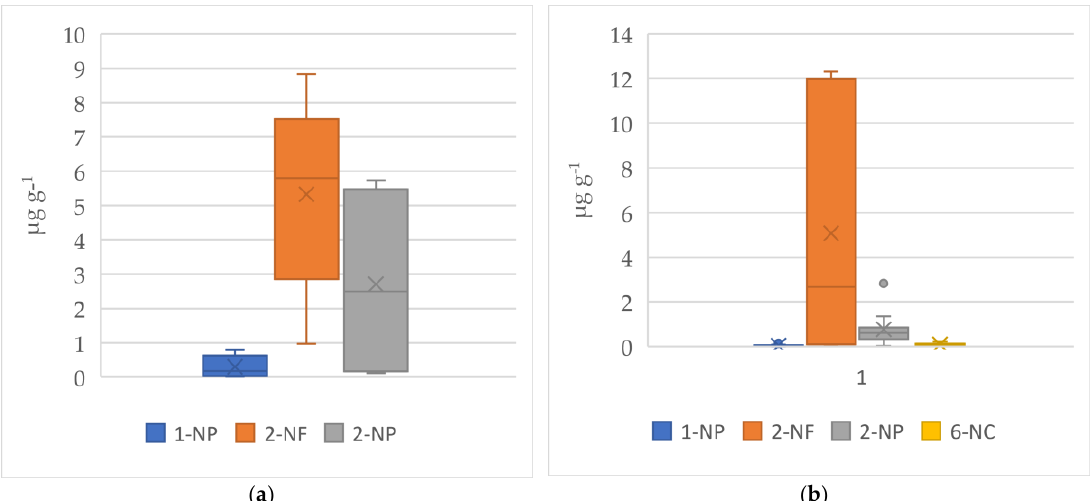
Figure 6. Distribution of individual NPAH in PM 2.5 : ( a ) background samples; ( b ) RS burning samples. X marker in each bar chart: the mean of NPAH content. Dash in each bar chart: the median of NPAH content.